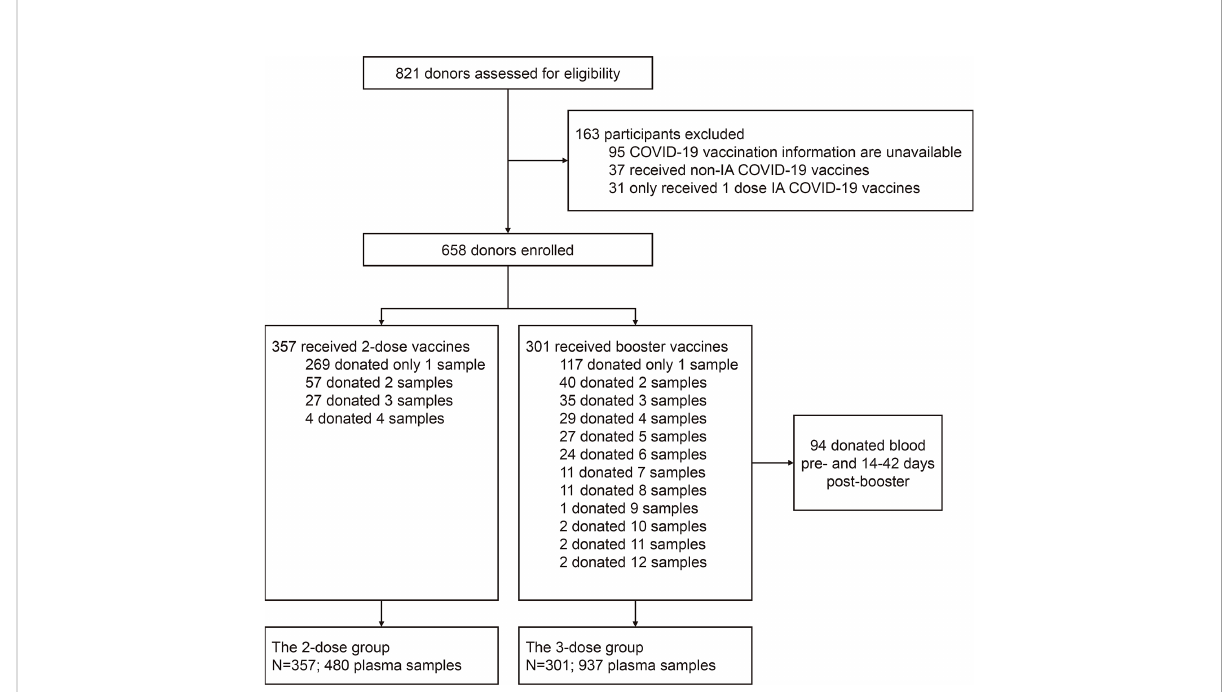
FIGURE 1 Flow chart describing the study cohort enrollment. The enrolled 658 donors were divided into two groups (the 2-dose and 3-dose groups) according to whether the people received the 3 rd booster vaccination during the study period. Among all subjects, 386 only donated their blood once, and the remaining 272 donated blood twice or more. IA-COVID-19 vaccine, inactivated COVID-19